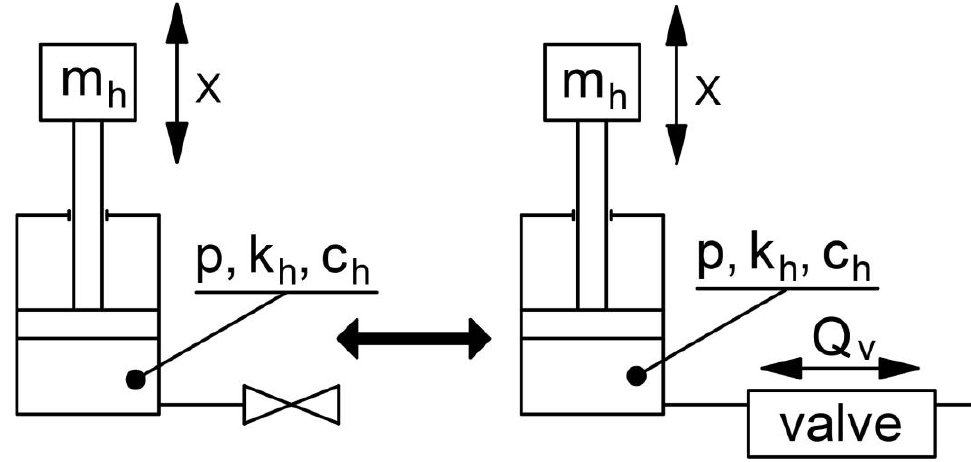
Figure 2. Dynamic model of a hydraulic system with allowance for the dynamic response of the